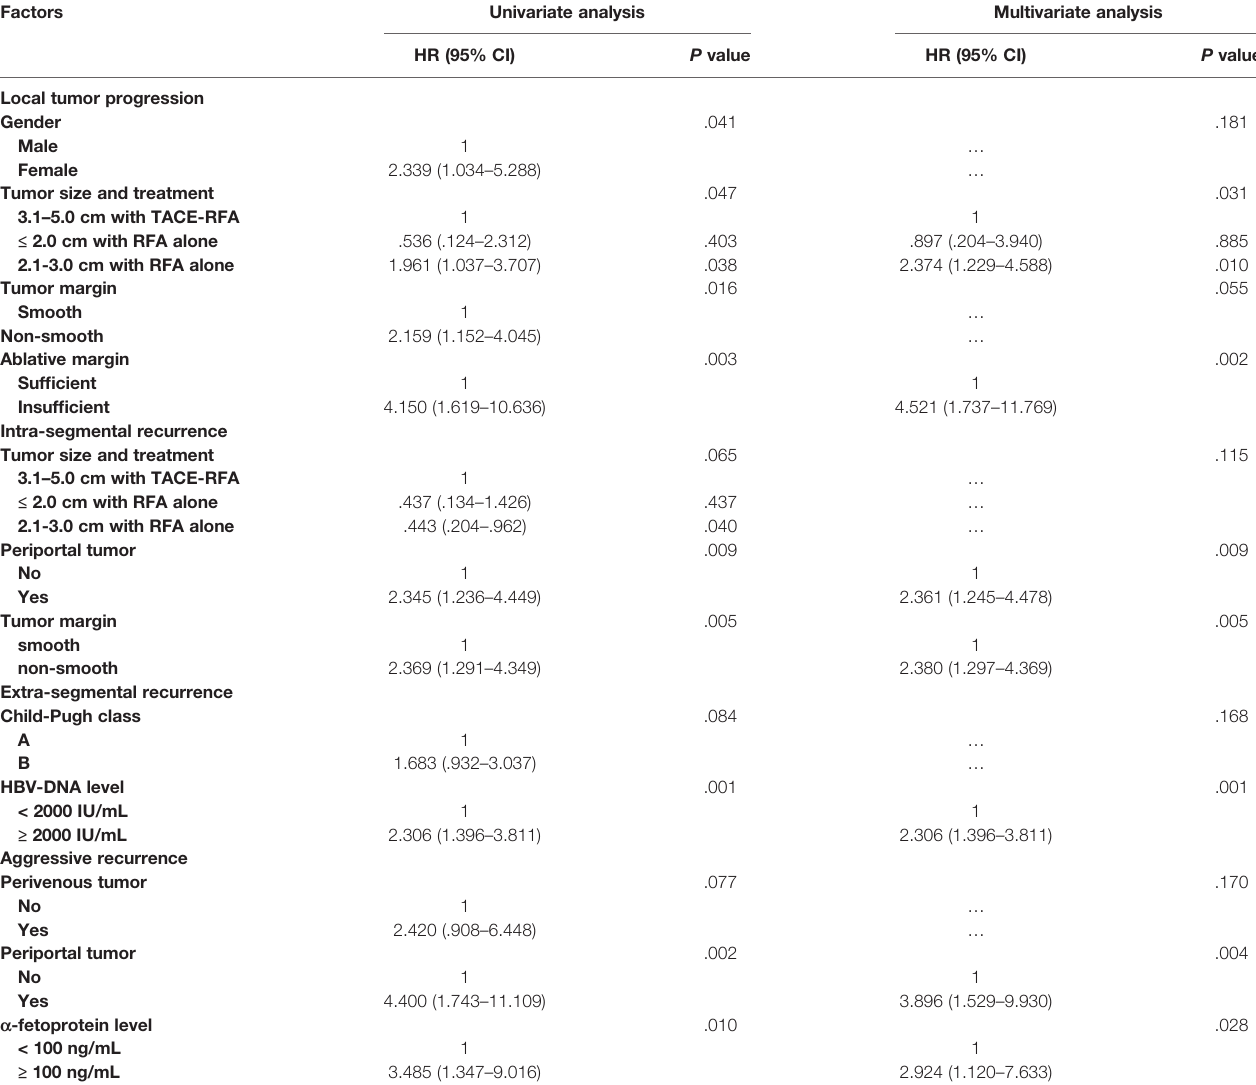
TABLE 4 | Univariate and multivariate analysis of the risk factors for different recurrence